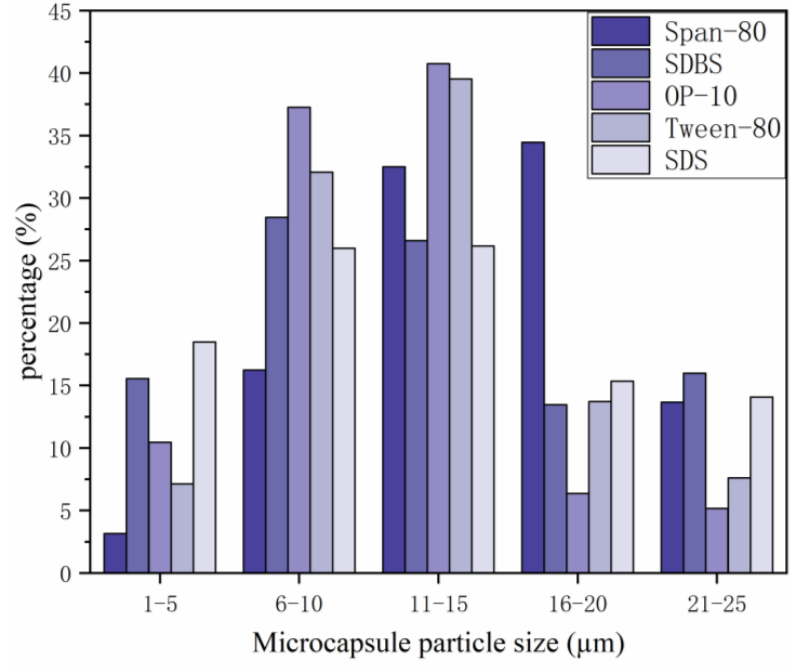
Figure 3. Particle size distribution of five emulsifier microcapsules.